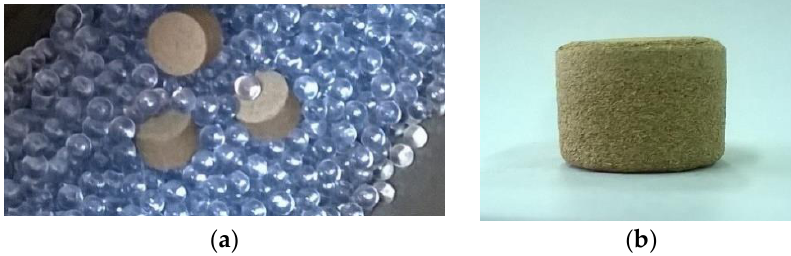
Figure 5. Test pellet sample: ( a ) the ballast material placed in the testing chamber, ( b ) after test with the visible crumbling zones.